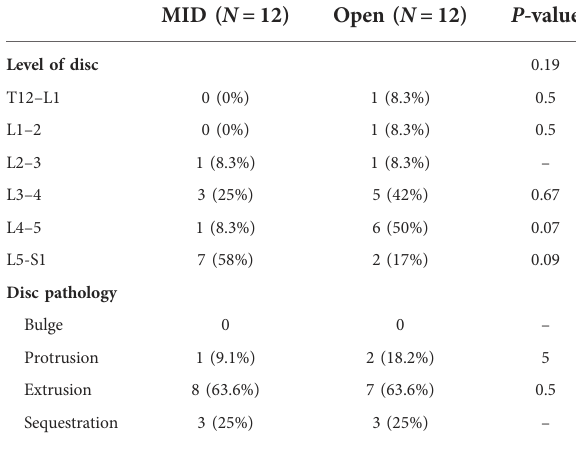
TABLE 2 Preoperative radiological data. TABLE 1 Demographic and clinical